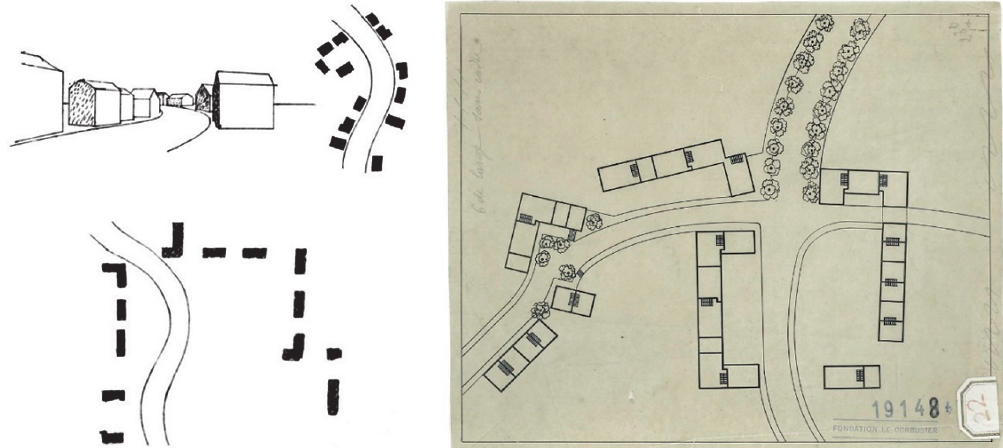
fig. 11. left. Curved streets in Urbanisme (le Corbusier 1925). right. a ‘Dom-ino’ neighbourhood (flC